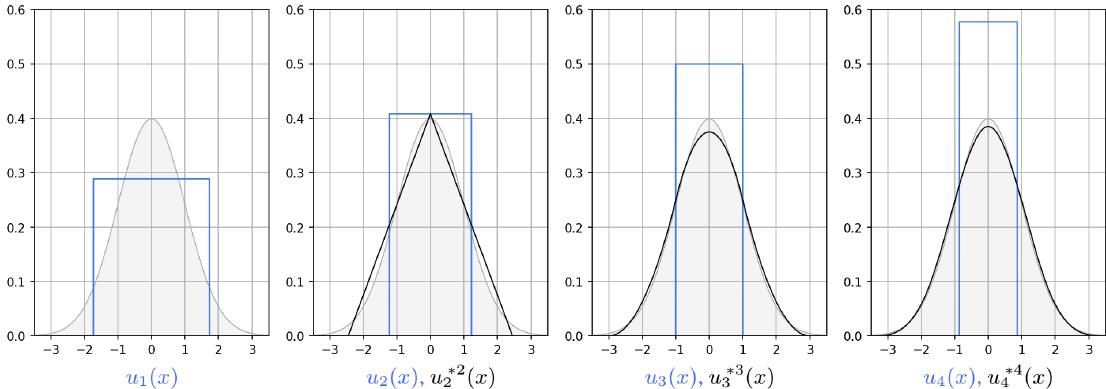
Figure 1. From left to right, blue indicates the plot of the PDFs of the uniform distributions u 1 (x) , u 2 (x) , u 3 (x) and u 4 (x) for σ = 1; black (x) , u ∗ 3 (x) and u ∗ 4 (x) . The area covered by the PDF of the normal distribution is indicated in shows their self-convolutions u ∗ 2 2 3 4